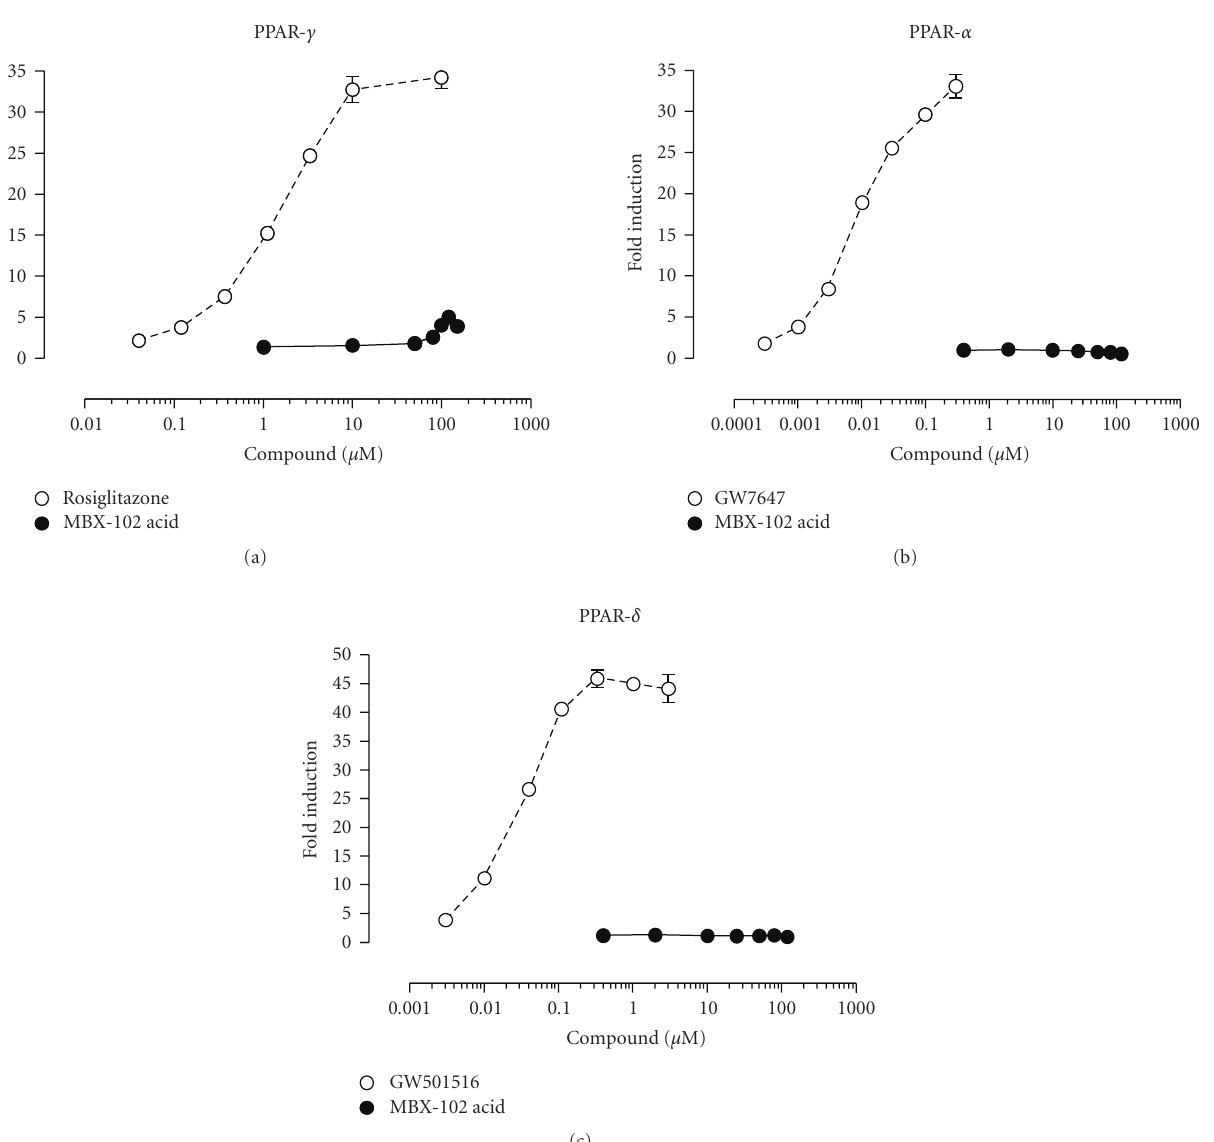
Figure 2: Gal4 Reporter assay data for mouse PPAR- γ (a), mouse PPAR- α (b), and mouse PPAR- δ (c). Values are plotted as mean ± SEM and are representative of at least 2 independent